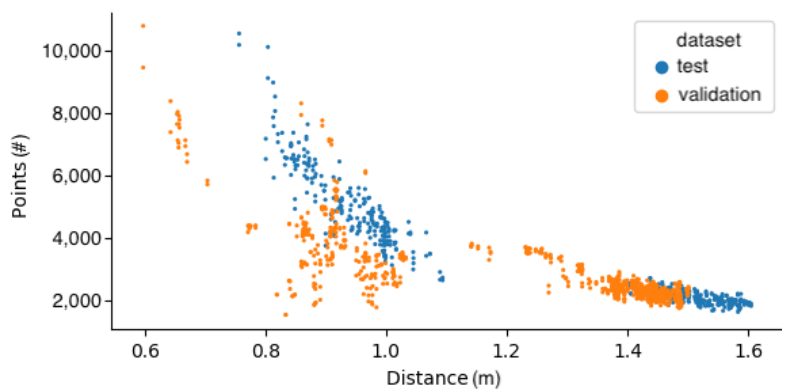
Figure 9. Number of points in crops relative to the distance from the camera.